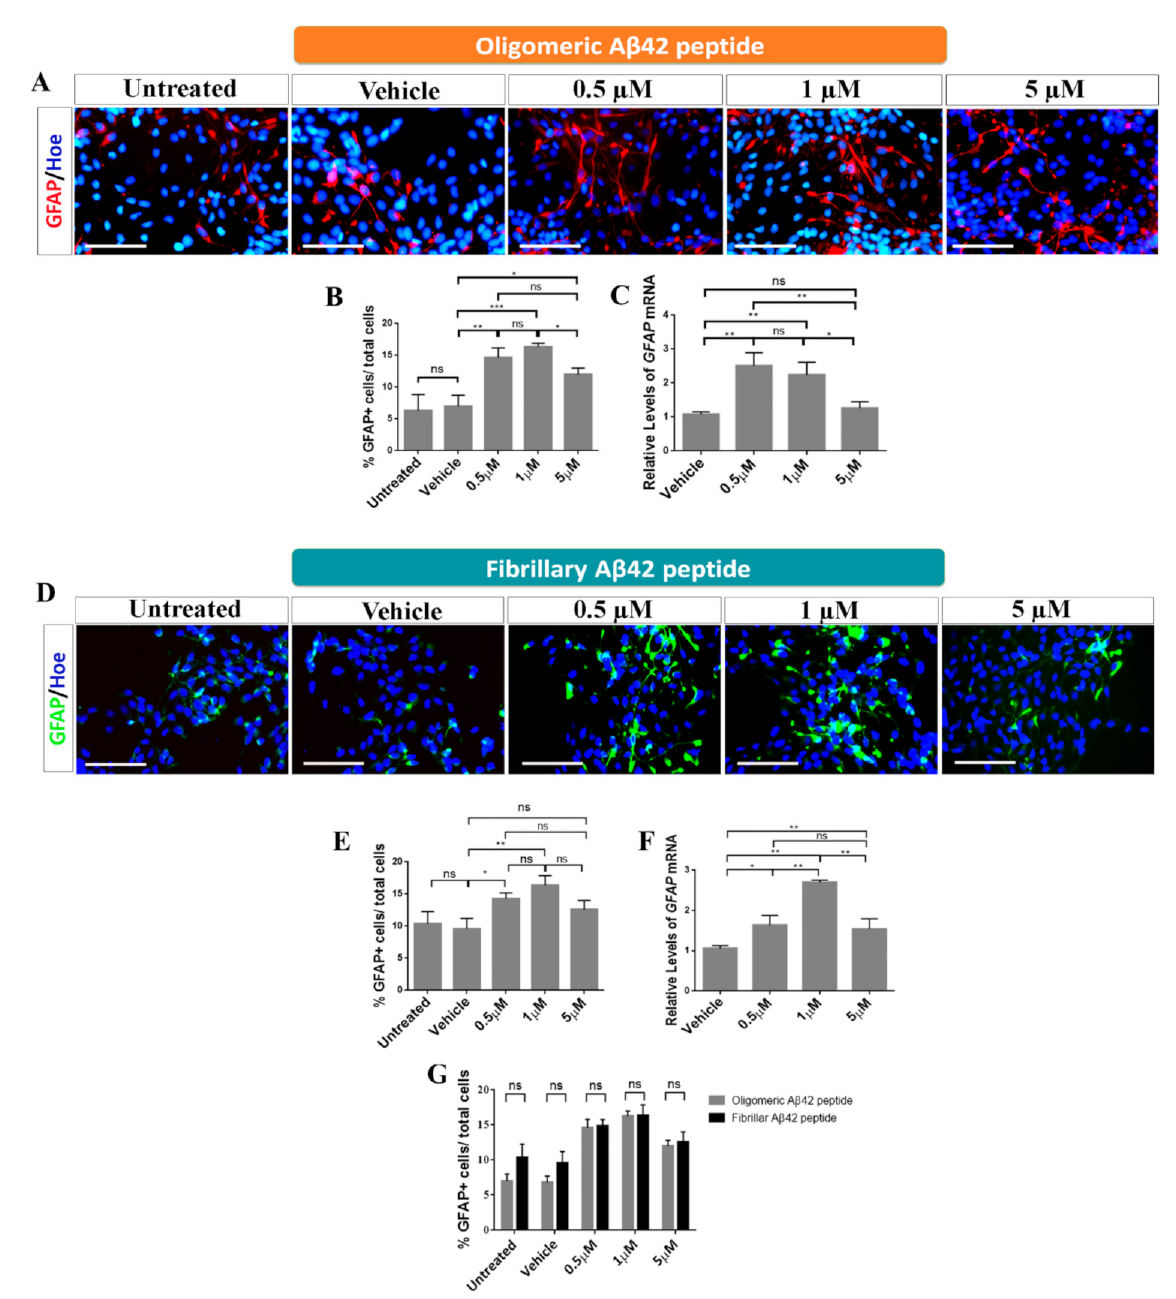
Figure 5. Role of oligomeric and fibrillary A β 42 in gliogenesis. ( A ) Immunoreactivity for GFAP (red) after oligomeric A β 42 treatment. Scale bar, 50 µ M. ( B ) Analysis of the percentage of GFAP+/total cells in the different groups tested after oligomeric A β 42 treatment. ( C ) Relative expression levels of GFAP mRNA obtained by qRT-PCR after oligomeric A β 42 treatment. ( D ) Immunoreactivity for GFAP (green) after fibrillary A β 42 treatment. Scale bar, 50 µ M. ( E ) Analysis of the percentage of GFAP+/total cells in the different groups tested after fibrillary A β 42 treatment. ( F ) Relative expression levels of GFAP mRNA obtained by qRT-PCR after fibrillary A β 42 treatment. ( G ) Percentage of GFAP+/total cells comparing both added forms. Cell nuclei in A and D were counterstained by Höechst (blue). Data are represented as means ± SD of at least three different experiments ( n = 3). Statistical significance of one-way ANOVA with post hoc Tukey test; * p < 0.05; ** p < 0.01; *** p < 0.001; ns = not